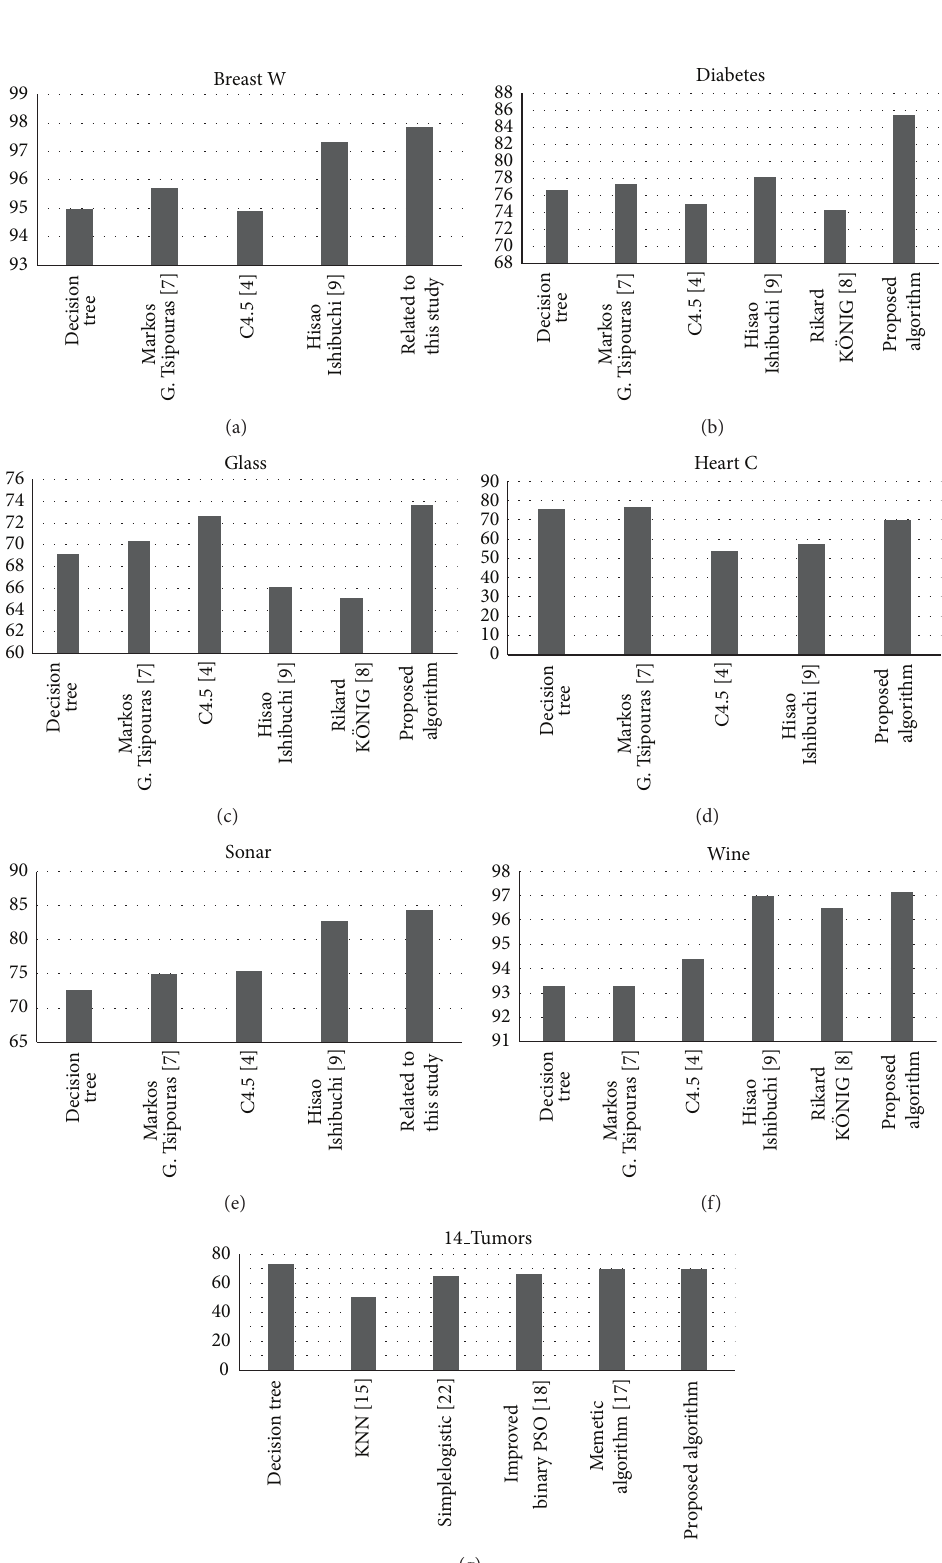
Figure 9: Classification rate of HYEI versus several famous classification